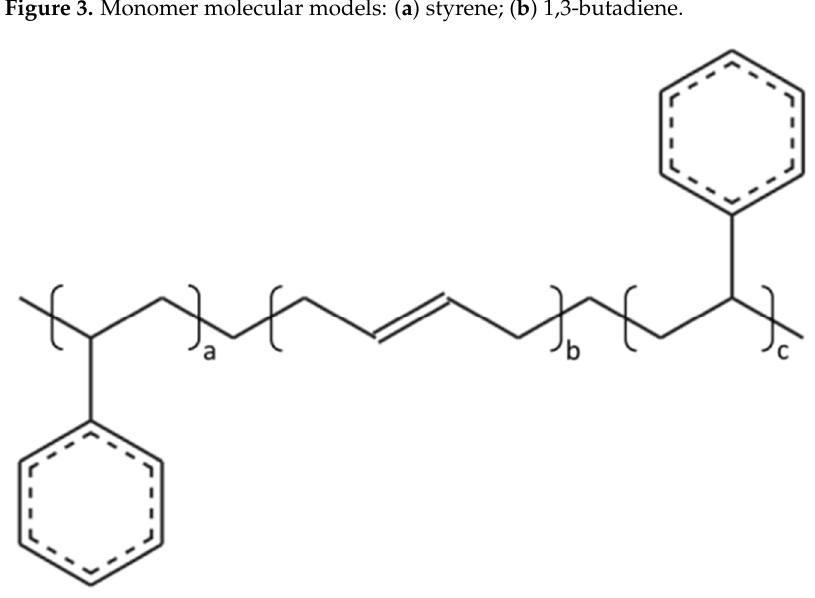
Figure 4. Molecular formula of linear SBS.